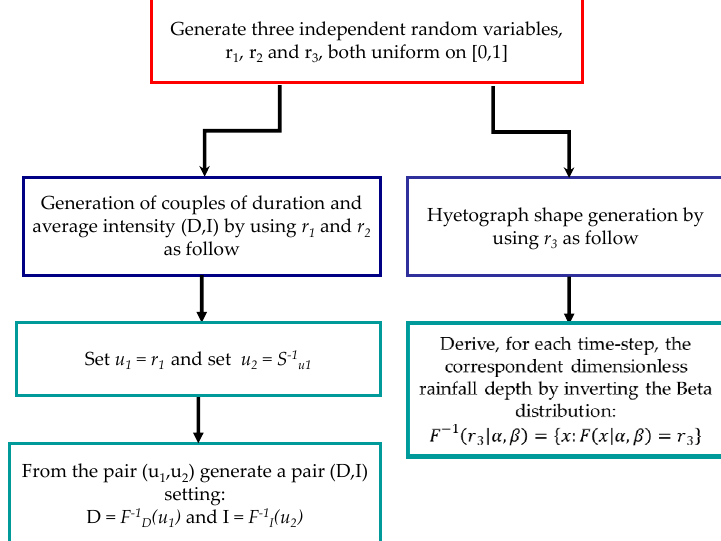
Figure 8. Flow diagram of the Monte Carlo simulation.